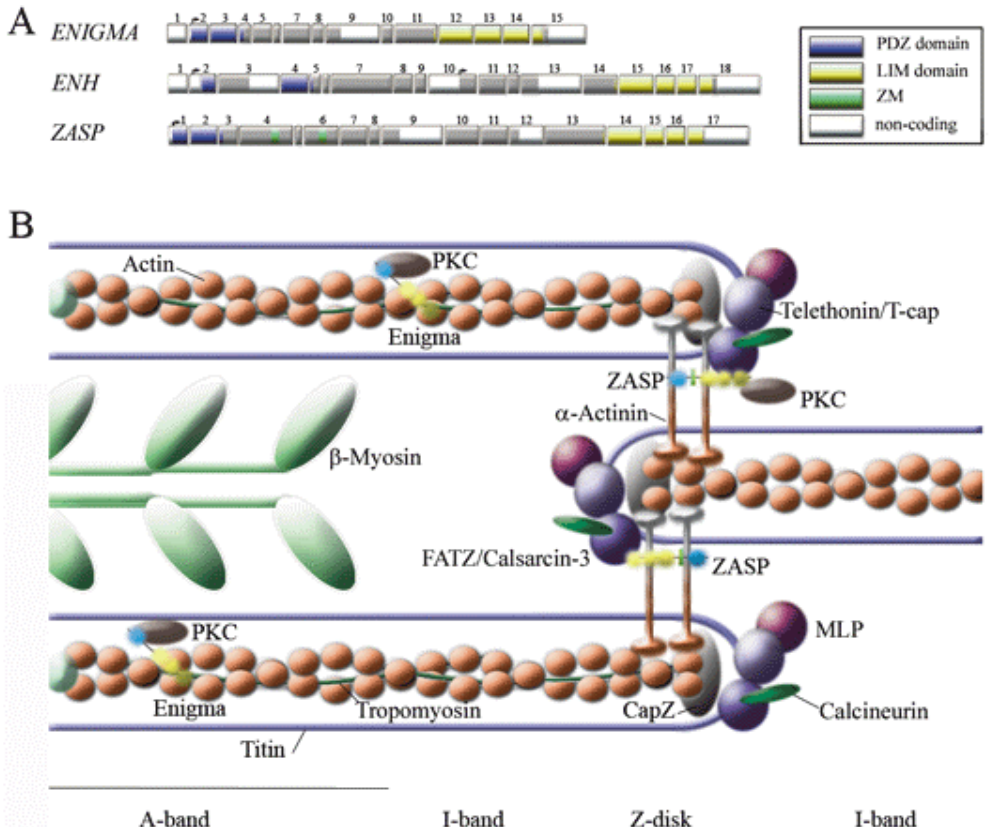
FIGURE 1 . (A) The gene structures of the Enigma subfamily. Shown are the gene structures of the human Enigma subfamily genes based on Ensembl data. Illustrated are ZASP (ENSG00000122367), ENIGMA (ENSG00000196923), ENH (ENSG00000163110). In blue and yellow, the exons encoding the PDZ and LIM domain are indicated, respectively. In green, the ZASP-like motif is pointed out. (B) The Enigma subfamily and its interaction with the cytoskeleton. A simplified overview of the proteins present at the Z-disk and the I-band of the sarcomere. The major sarcomere protein titin interacts with telethonin at a 2:1 ratio and is further in complex with α -actinin[153]. The teletonin-titin complex attracts proteins like MLP and calsarcin-3 (FATZ). The actin filaments from two antiparallel sarcomeres are interconnected by α -actinin, while further cross-linking is mediated by ZASP, which interacts with α -actinin, PKC, and calsarcin-3. PKC tethering to the sarcomere is important for functional regulation, such as force generation and mechanical integrity. Enigma also interacts with PKC, but is located at a different position due to the targeting of its PDZ domain to tropomyosin. Phosphorylation of troponin (present in close association with the actin filaments and tropomyosin; not shown here for simplicity) has been shown to be essential for Ca 2+ sensitivity of muscle